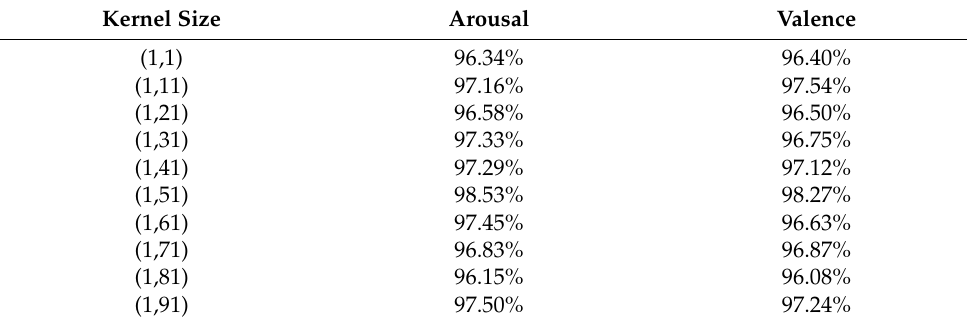
Figure 7. Diagram of temporal feature extraction using the Transformer algorithm. Table 1. The accuracy of arousal and valence classification based on kernel